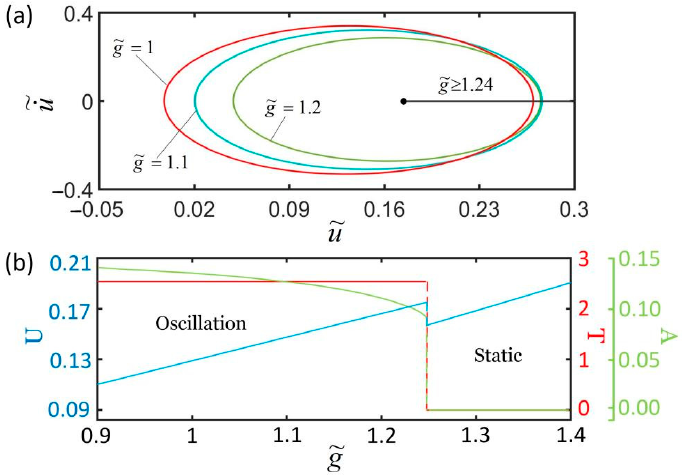
Figure 12. The effect of gravitational acceleration on self-excited oscillation for given values of 8.5~ 32.0~ = 1.1~ 0~ 0~ 24.0~ = c = u = k −=α = L = u  . ( a ) Limit cycles; . I , , , 25.0 , , , and u 0 = 0. ( a ) Limit cycles; ( b ) amplitude, 0 p 0 (cid:101) c = 0.24, α = − 0.25, (cid:101) I = 0.32, (cid:101) L p = 1.1, (cid:101) u 0 = 0, and (cid:101) ( b ) amplitude, period, and equilibrium position. There exists a critical gravitational acceleration 24.1~ = g for triggering self-excited oscillation.